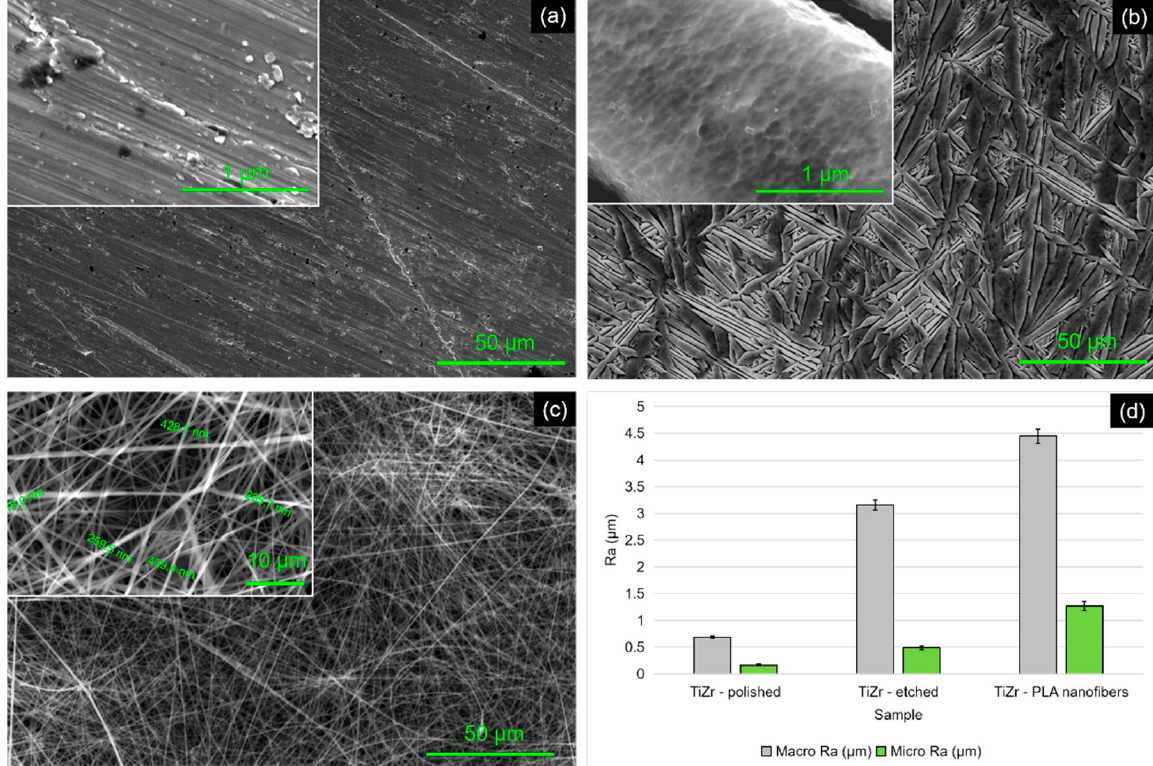
Figure 1. SEM micrographs for ( a ) polished TiZr; ( b ) etched TiZr; ( c ) etched TiZr covered with PLA nanofibers; Inset—higher magnifications; ( d ) average roughness values.